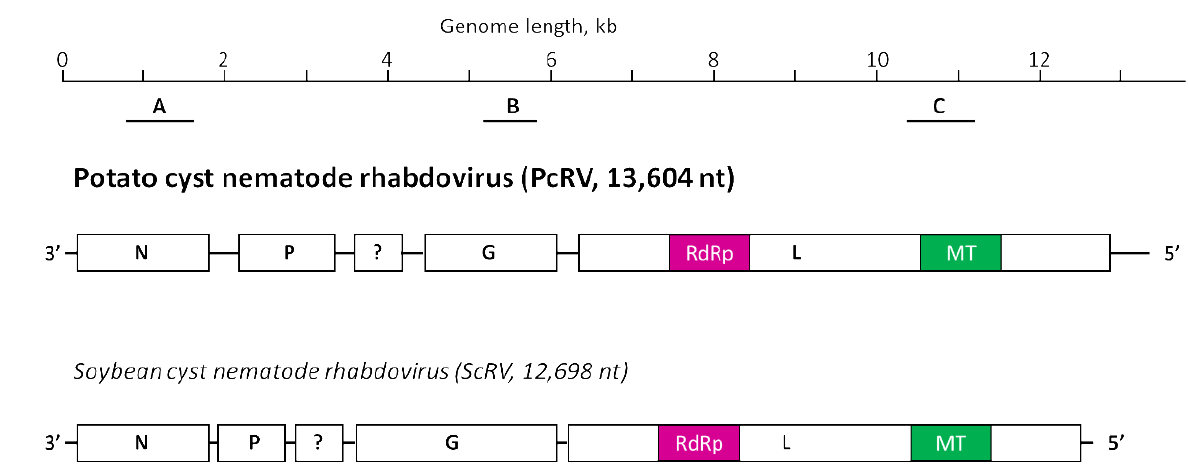
Figure 1. Schematic representation of the potato cyst nematode rhabdovirus (PcRV, GenBank acces- sion number OP903920) genome, presented in a negative-sense virion form, in comparison to the genome organization of soybean cyst nematode rhabdovirus (ScRV, HM849039). Four rhabdovirus- specific genes, N, P, G, and L, are designated; a question mark is placed on an unknown gene. Homologous protein domains encoded in L proteins of both virus genomes, RdRP (RNA-dependent polymerase) and methyltransferase (MT), are also marked with like colors. The black bars below the PcRV genome represent the location of the PCR fragments obtained using the primer pairs for testing by RT-PCR (A, PcRV1_F/R; B, PcRV2_F/R; C, PcRV3_F/R); for primer details, see